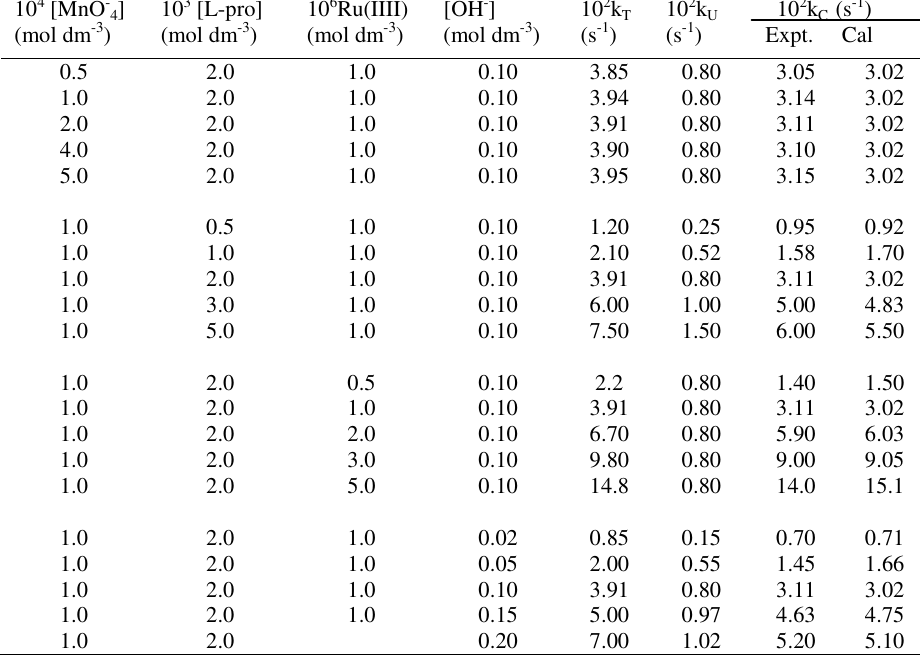
Table 1. Effect of variation of [MnO 4- ], [L-proline], [Ru(III)] and [OH - ] on oxidation of L-proline